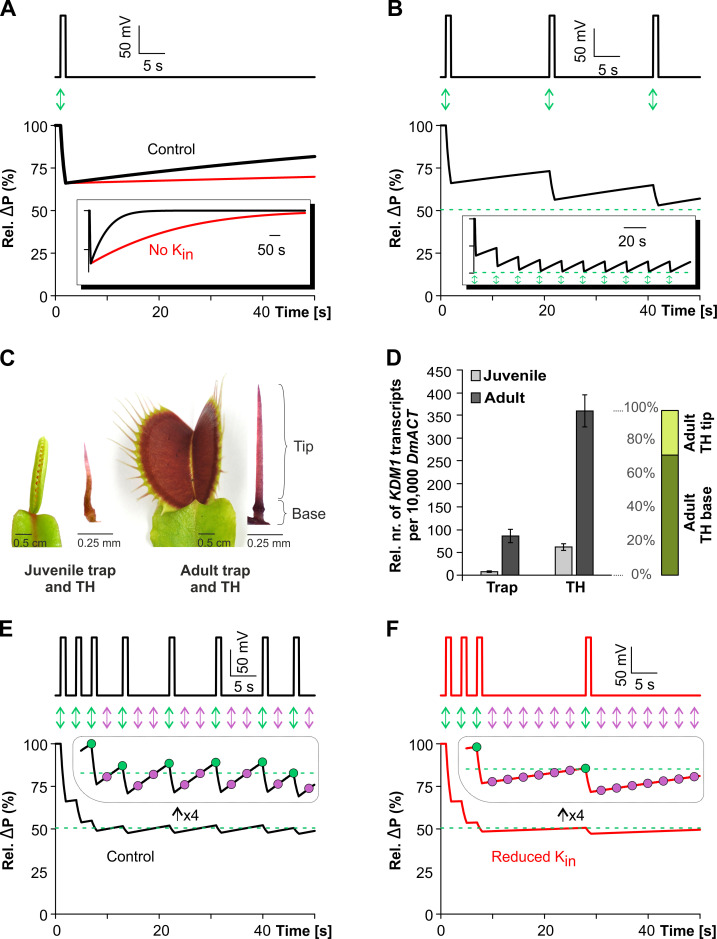
Reduced K+in channel activity increases recovery lag time after AP firing.(A) A mechanical stimulus (green arrow) initiates an AP (upper panel) during which the accompanied ion and water fluxes reduce the cell turgor (lower panel). In the following recovery phase, the initial condition is slowly reestablished (inset shows the recovery on a larger timescale). Reduced activity of K+in channels significantly slows down the recovery process (red curve). (B) When the THs are stimulated with low frequency (green arrows), the interval is insufficient for a full recovery of the cell. Over time, however, a new working range is established that is still above the turgor threshold (green) as seen in the inset. (C) Juvenile trap with the corresponding juvenile TH and adult trap with the corresponding adult and electrically excitable TH. (D) Normalized expression values of KDM1 quantified by qPCR in trap and THs in juvenile and adult stages (mean normalized to 10,000 actin (± SE), n = 3–6; t test between whole adult trap and adult TH p-value = 0.00038). The proportion of KDM1 expression within the dissected adult TH shows a dominant (up to 70%) expression level in the base of the TH (containing the sensory cells), (n = 3; mean ± SE). The full raw dataset and statistical analysis is provided in S3 Data. (E) Increasing the frequency of the stimulus causes the turgor to fall below the threshold. In this condition, a mechanical stimulus may not initiate an AP and sporadic dropouts occur (purple arrows, purple dots in the enlarged view in the inset). (F) High-frequency stimulation in conditions with reduced K+in channel activity results in larger dropout intervals. Initially, however, as long as the cell still has reserves, APs are initiated as in the control case. AP, action potential; qPCR, quantitative polymerase chain reaction; SE, standard error; TH, trigger hair.